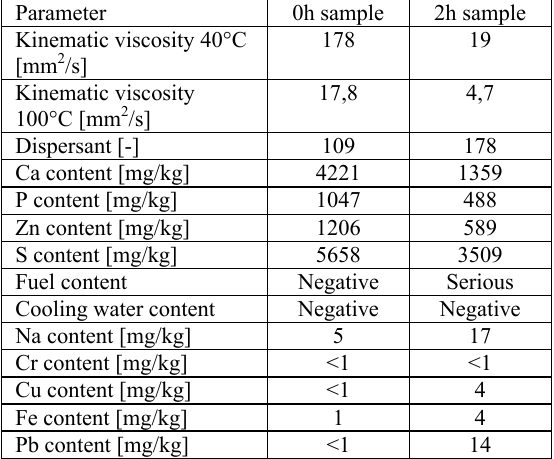
Table 1. Comparison of the LubCheck results of the 0h reference and 2h engine oil sample